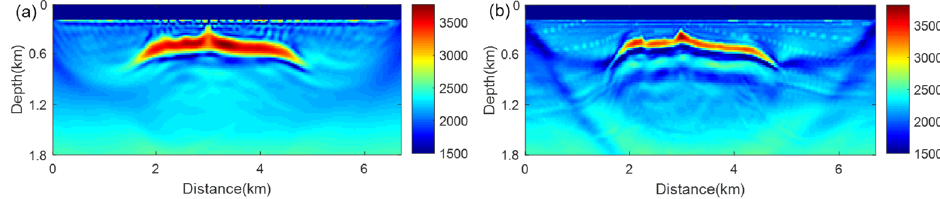
Figure 12. Conventional EI results. ( a ) Conventional EI result. ( b ) Conventional EI + FWI result.